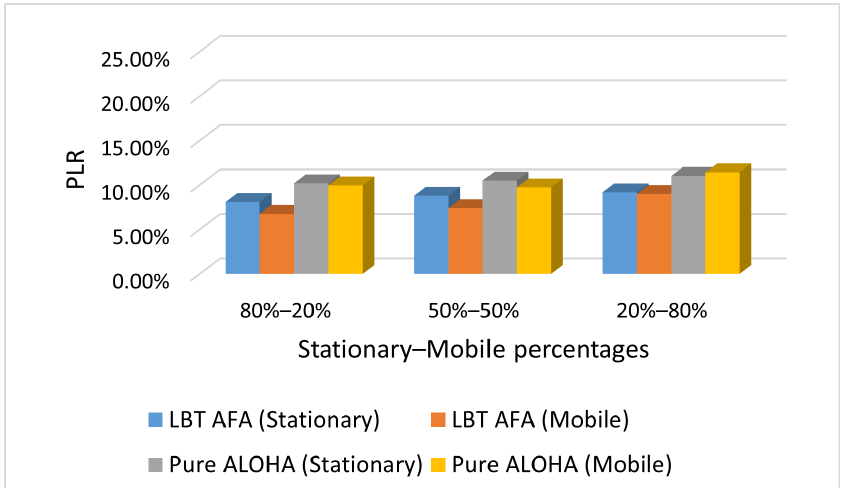
Figure 8. Case M: PLR with varying percentages of stationary and mobile end-devices.